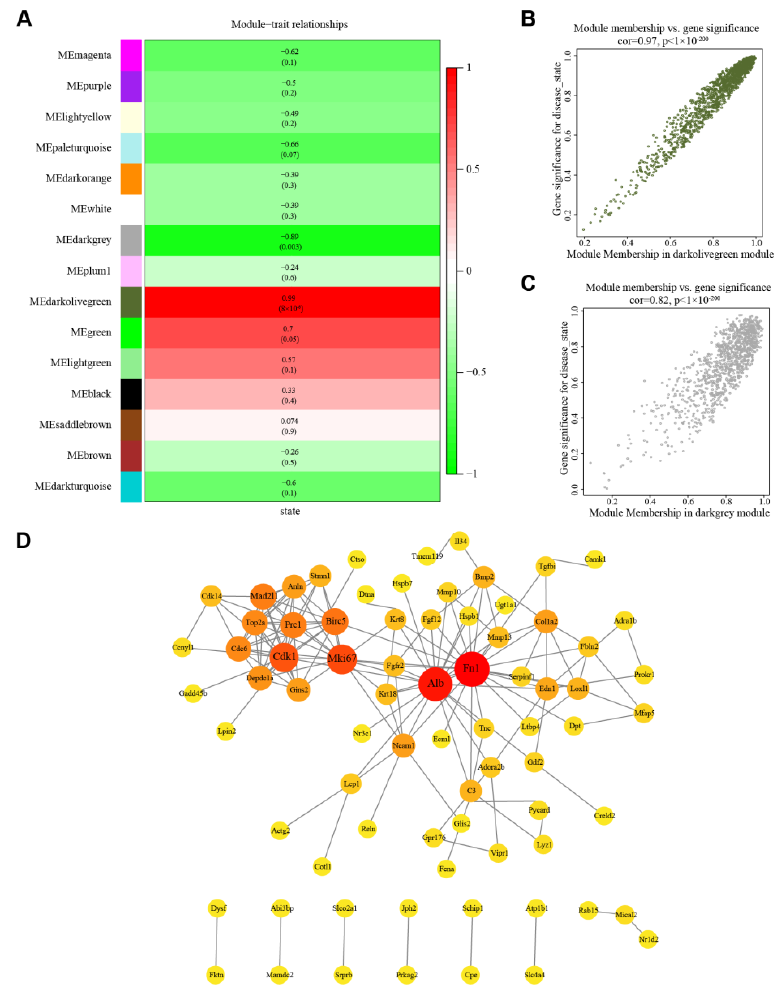
Figure 1. Identification of significant modules and key genes. ( A ) The relationship between modules and cell states. Cell states included quiescent and activated HSCs. ( B ) A scatter plot of darkolivegreen module genes and cell states. ( C ) A scatter plot of darkgrey module genes and cell states. ( D ) A PPI network of key genes using the online tool, STRING. HSCs, hepatic stellate cells; PPI, protein–protein interaction network.